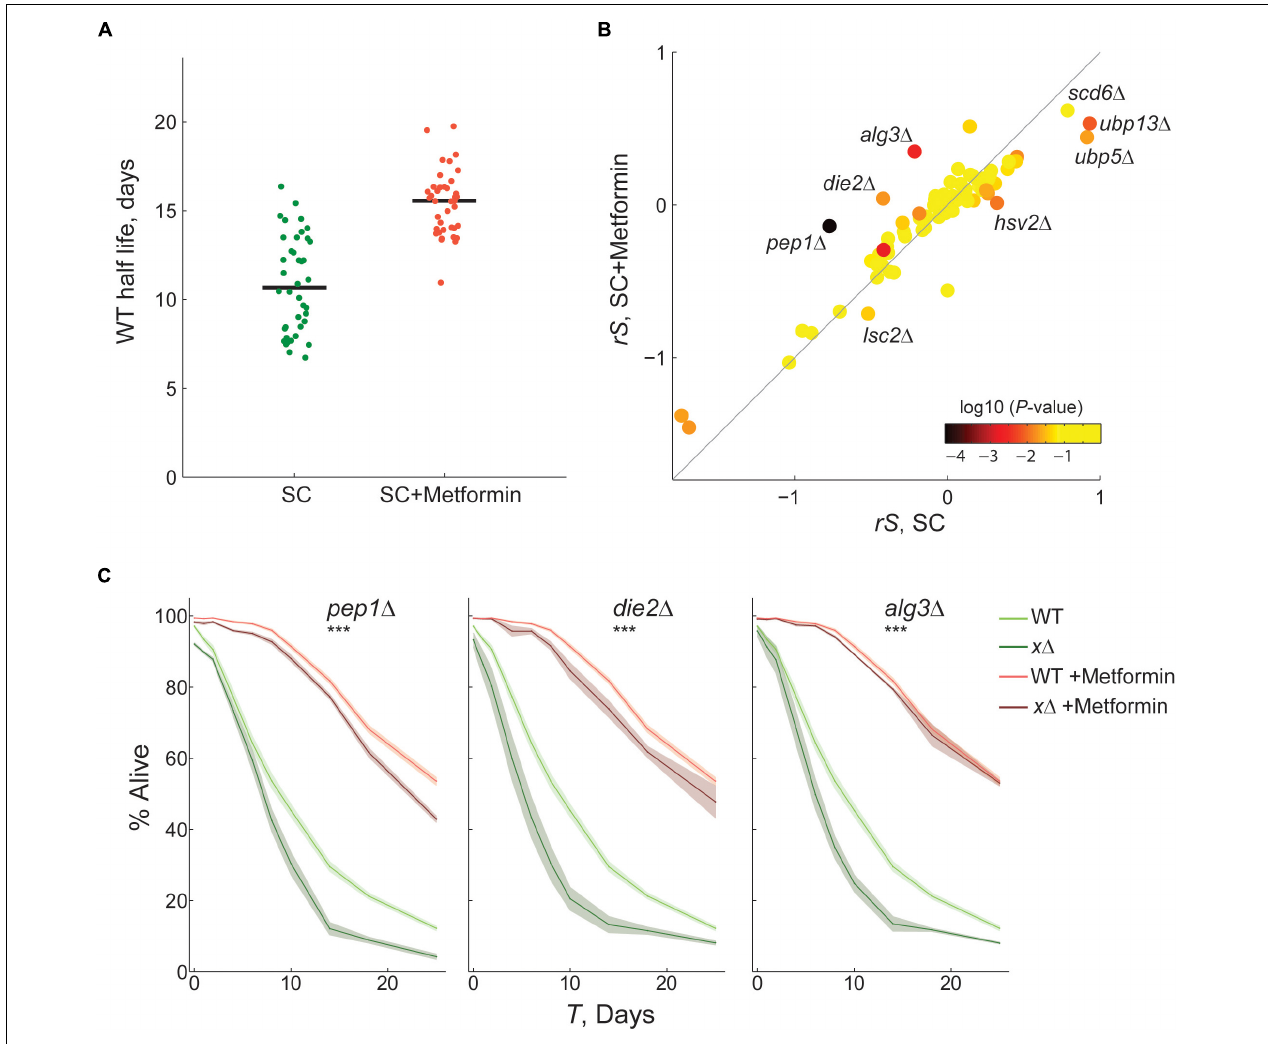
FIGURE 3 | Identification of gene-drug interactions by competitive-aging screening. (A) Half life of WT-reference samples with ( n = 39) or without metformin ( n = 40). (B) Scatter plot comparing the CLS phenotypes of 76 gene-deletion strains with or without metformin; the average rescaled relative survivorship rS shown of four replicates is shown. Color scale indicates the p- value of paired t -tests between the S in SC and SC + Metformin. (C) Gene-drug interactions confirmed by live/dead staining. Survival curves of wild-type (light colors) and gene-deletion (dark colors) strains in nominal SC medium (green) or SC + metformin (orange); 95% CI were calculated from at least three replicates (shaded area). The interaction between metformin and gene-deletions was scored significant by two-way ANOVA tests of the death rates (*** p <